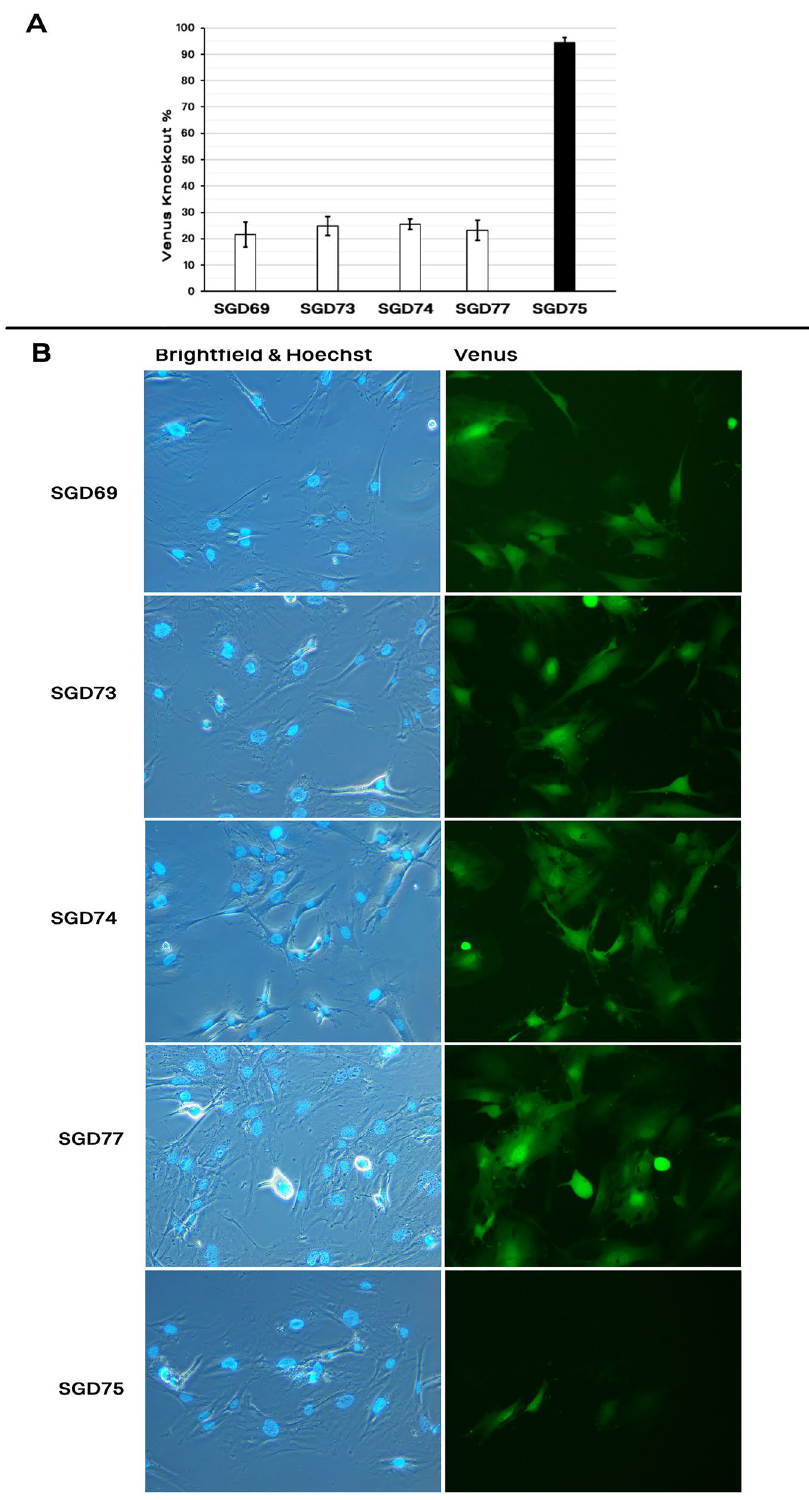
Figure 7. E ffect of nocodazole on the HDR rate. MEF cells were electrotransfected with pSGD plasmids carrying both the CRISPR system and DNA donor in the presence of nocodazole into the electroporation media (70 ng/µl final concentration). The pSGD75 plasmid associated with both NHEJ- and HDR-induced Venus knock-out. ( A ) the HDR-mediated Venus knock-out rate using SGD cassettes. ( B ) Fluorescence microscopy of MEF cells electroporated with the pSGD